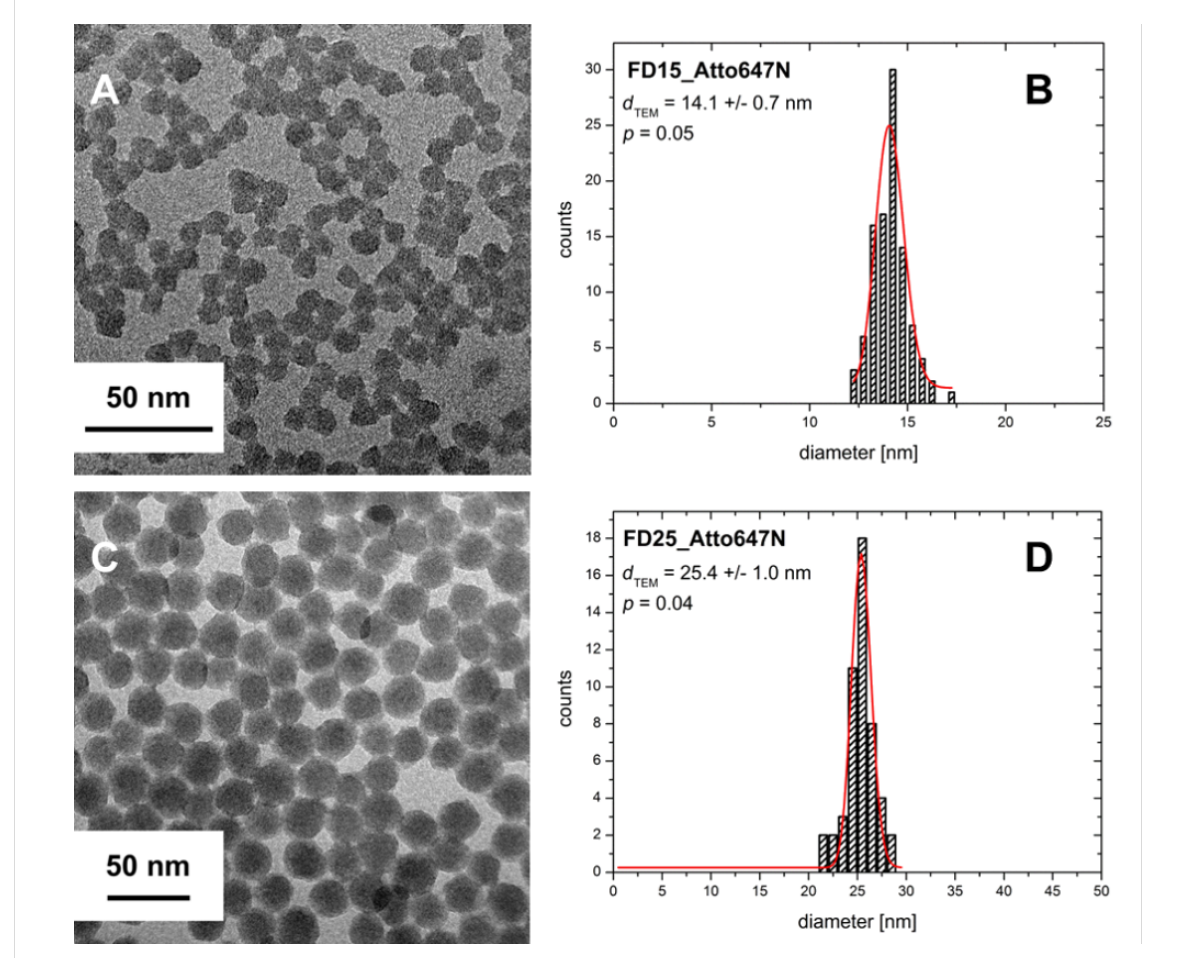
Figure 1: TEM images and size histograms of the Atto647N-doped silica nanoparticles. A: TEM image of FD15_Atto647N particles; B: size histogram derived from the TEM image of FD15_Atto647N; C: TEM image of FD25_Atto647N particles; D: size histogram derived from the TEM image of FD25_Atto647N.